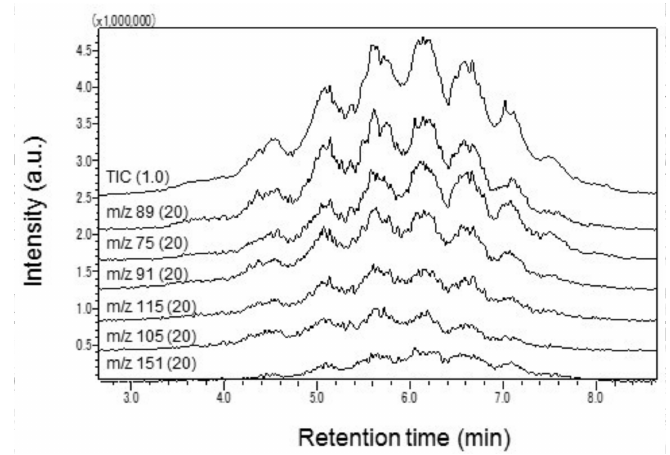
Figure 1. Major ion signals specific to fragments of a SCCP standard solution. Ion current intensities, except for total ion chromatogram (TIC), are enlarged by 20 times. Ion signals are displayed to the same scale of vertical axis by shifting the base line. Numbers in parentheses indicate the